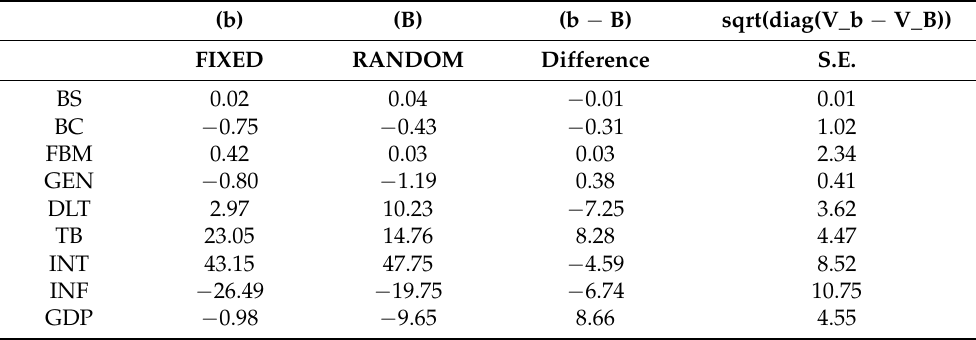
Table 7. Hausman Test